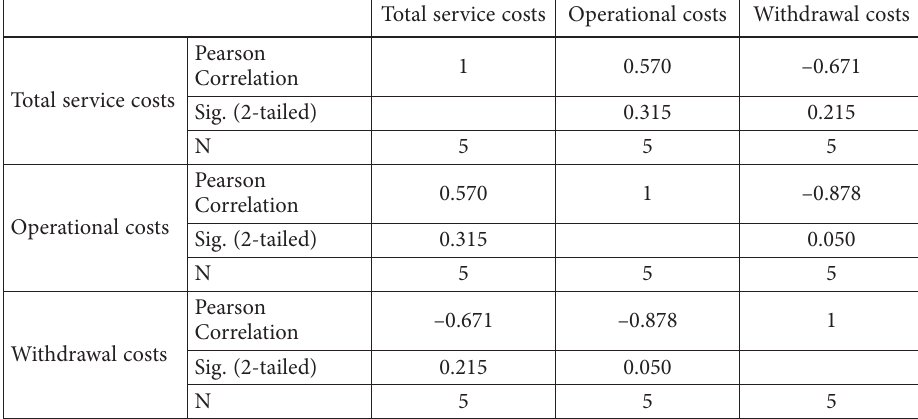
Table 14. Analysis of correlations between